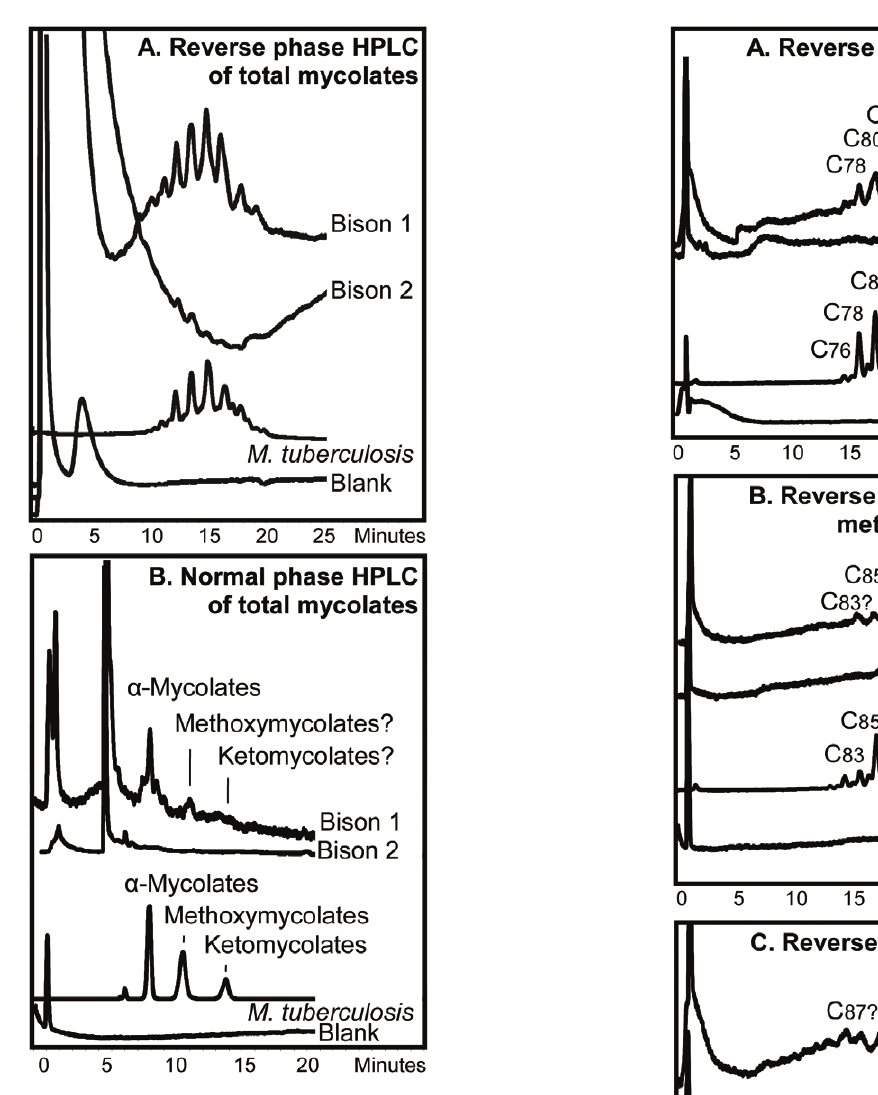
Figure 2. Fluorescence HPLC of pyrenebutyric acid derivatives of pentafluorobenzyl esters of total mycolic acids. The derivatives analysed were from Bison 1 and Bison 2 bones and standard M. tuberculosis . A. Reverse phase HPLC of total mycolates. B. Normal phase HPLC of total mycolates collected from reverse phase separations.